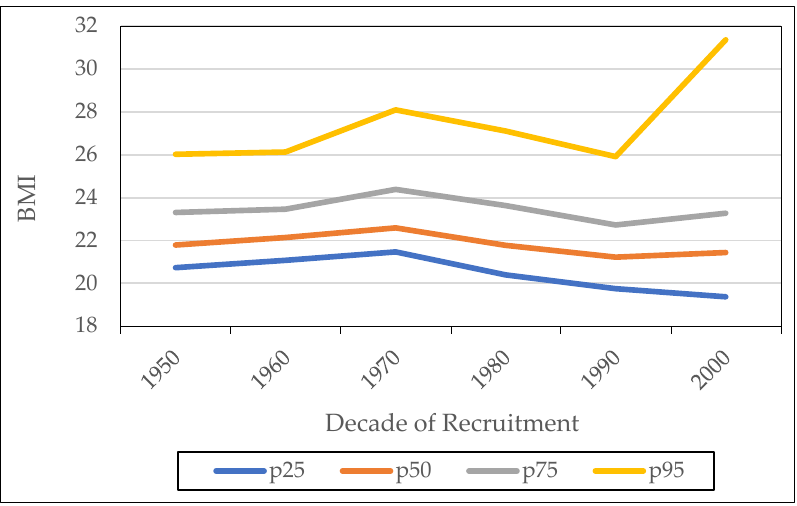
Figure 11. BMI percentiles by decade of recruitment Source: AMSB, ACDS. Own work.